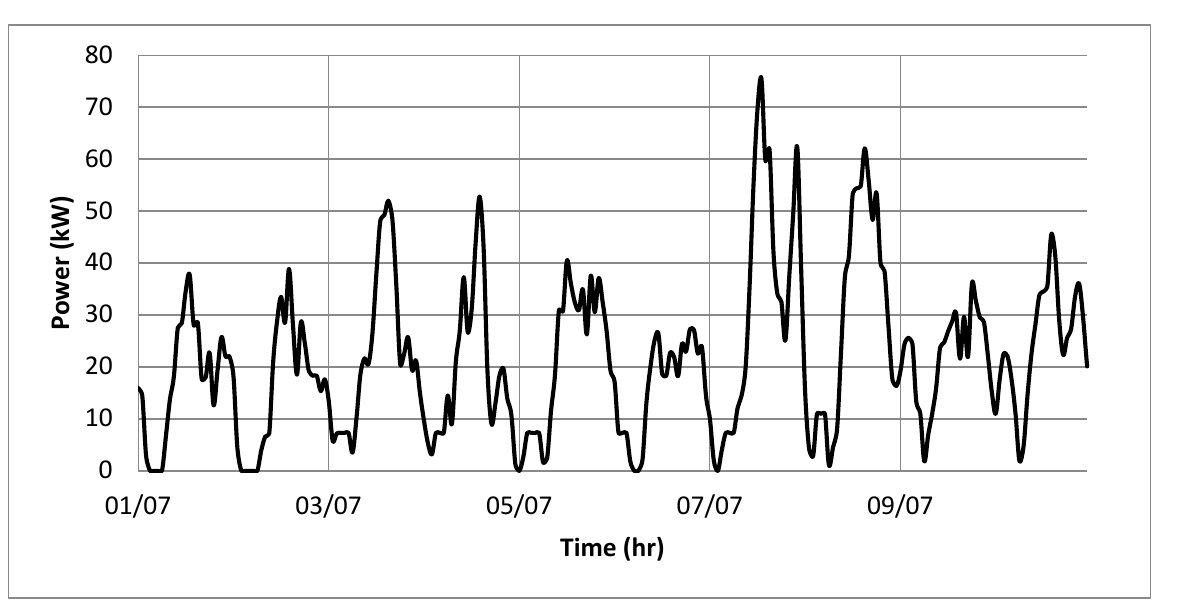
Figure 1. Generated EV-load profile. Table 2. Input parameters to generate EV load profile [29,30].